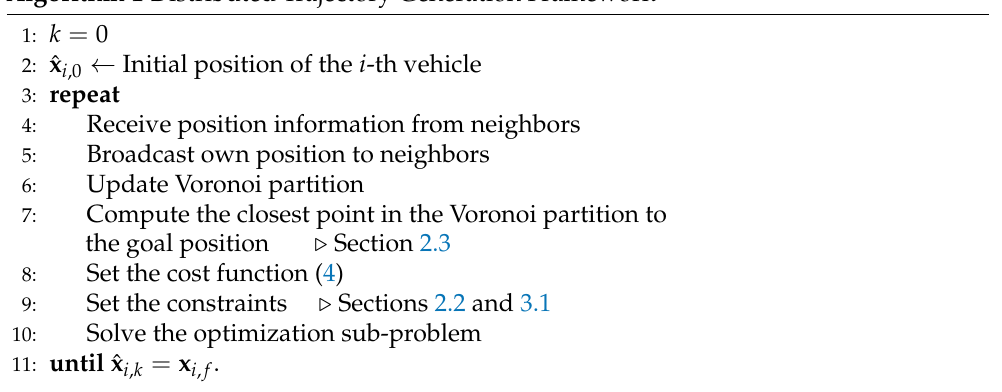
Algorithm 1 Distributed Trajectory Generation